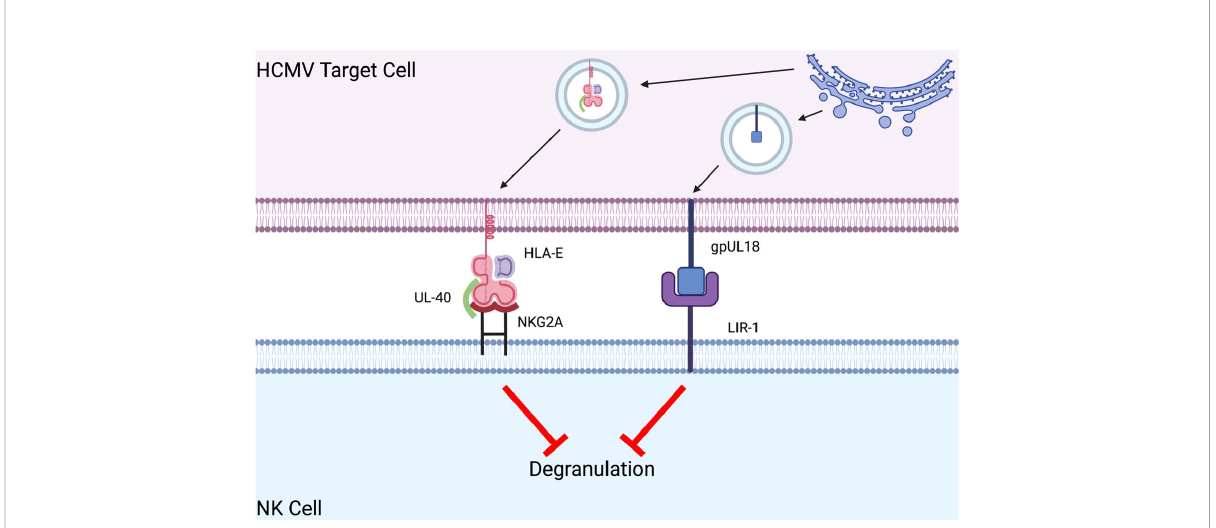
FIGURE 3 Human CMV evades NK cell destruction by amplifying inhibitory signaling. In human CMV (HCMV) infected target cells, UL40-bound HLA-E bind six-fold greater af fi nity to the NK cell inhibitory receptor NKG2A than HLA-E alone. HCMV gpUL18 is an MHC I decoy ligand that binds to the inhibitory NK cell receptor LIR-1 with a 1000-fold greater af fi nity than native MHC I molecules. These interactions result in a signi fi cant reduction in NK cell